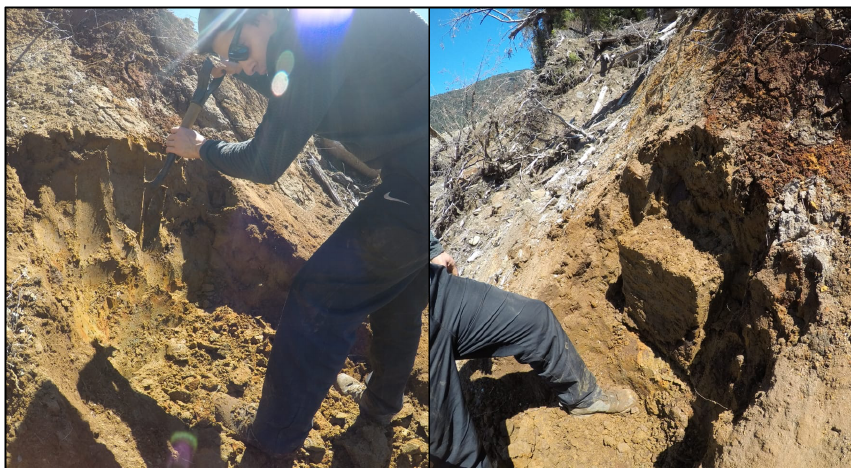
Figure 6. Extraction of an undisturbed soil